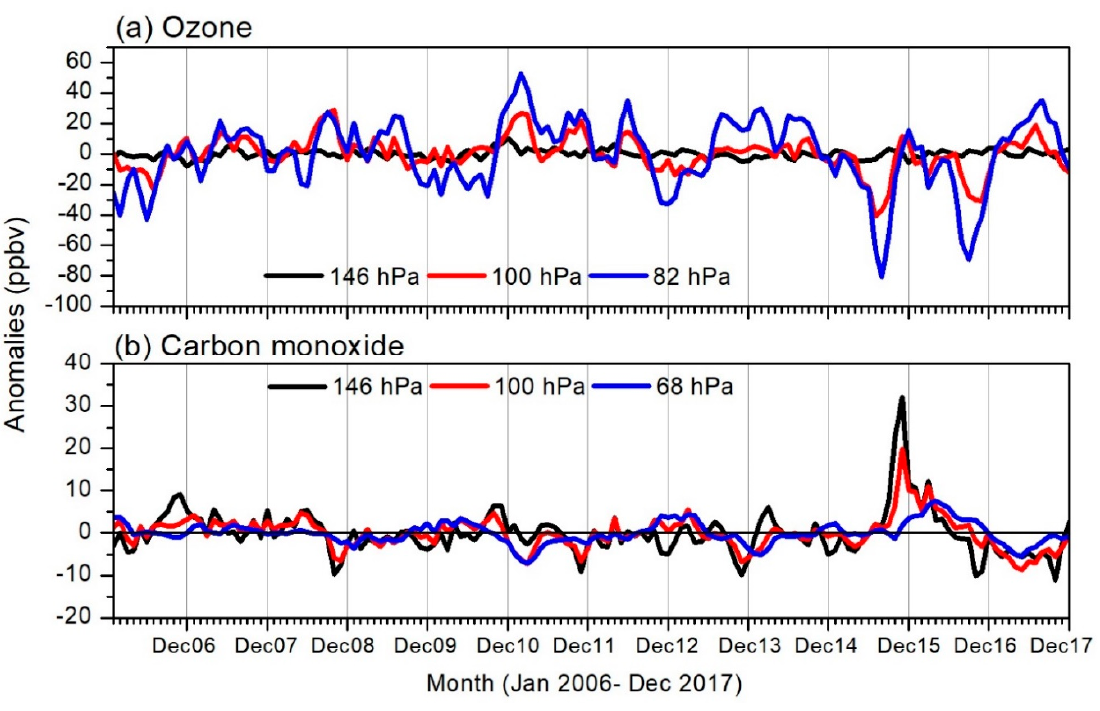
Figure 4. Time series of de-seasonalized anomalies of ( a ) ozone and ( b ) carbon monoxide observed over Equatorial region (10 ◦ N and 10 ◦ S) from January 2006 to December 2017. Different colours indicate different pressure levels.